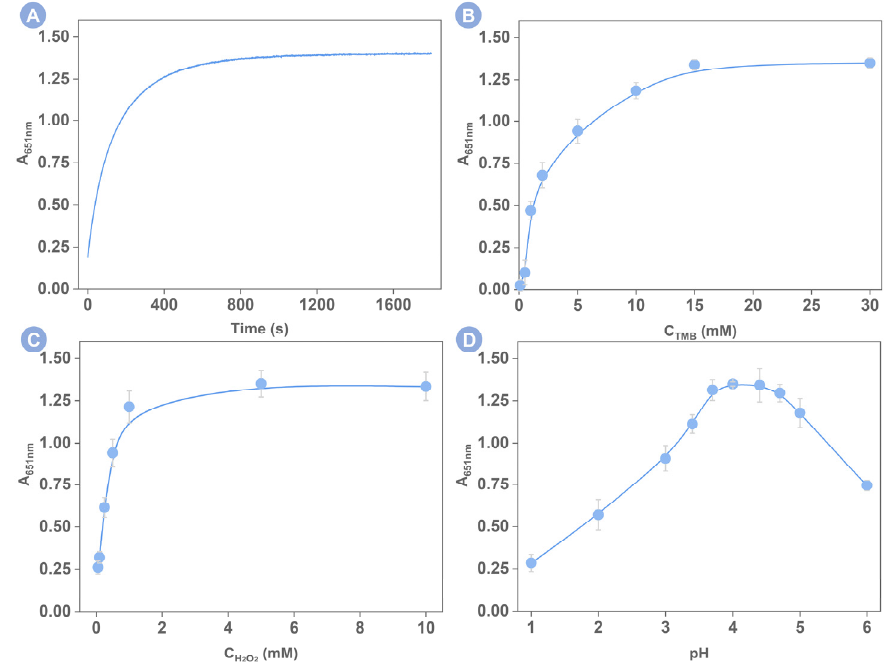
Figure 4. Influences of ( A ) the reaction time, ( B ) the concentration of TMB, ( C ) the concentration of H 2 O 2 , and ( D ) the pH of the reaction solution on the catalytic reaction between TMB and H 2 O 2 . Error bars were obtained from three repetitive experiments.